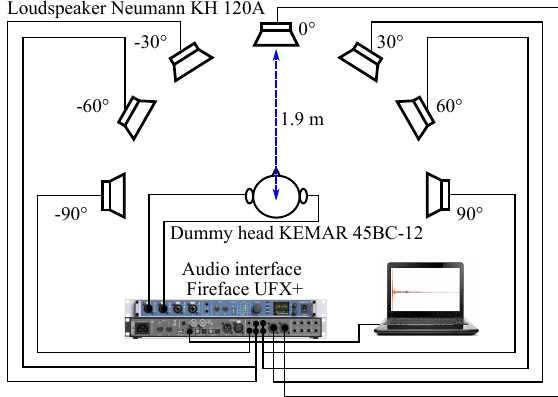
Figure 2. Illustration of the setup of BRIR